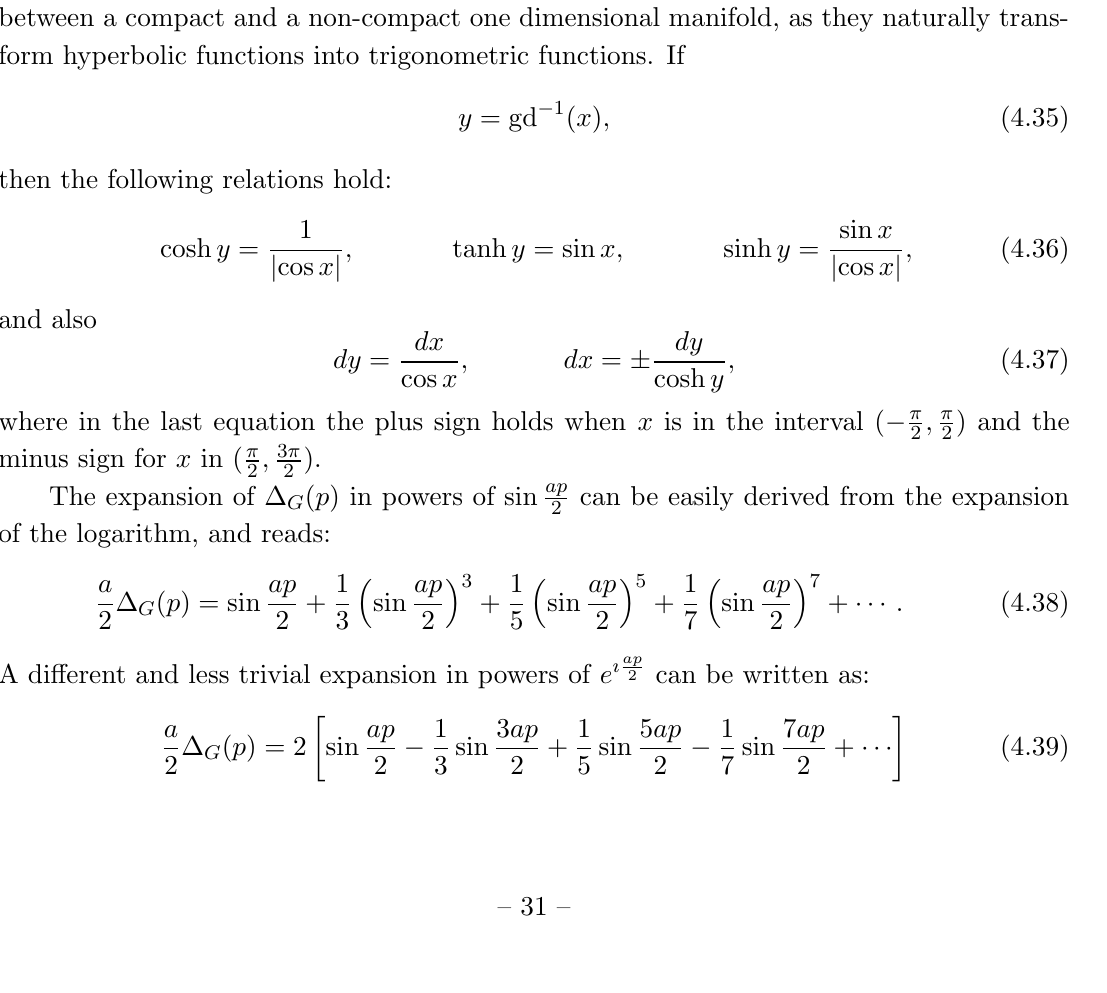
covers a 2 (cid:25) 2